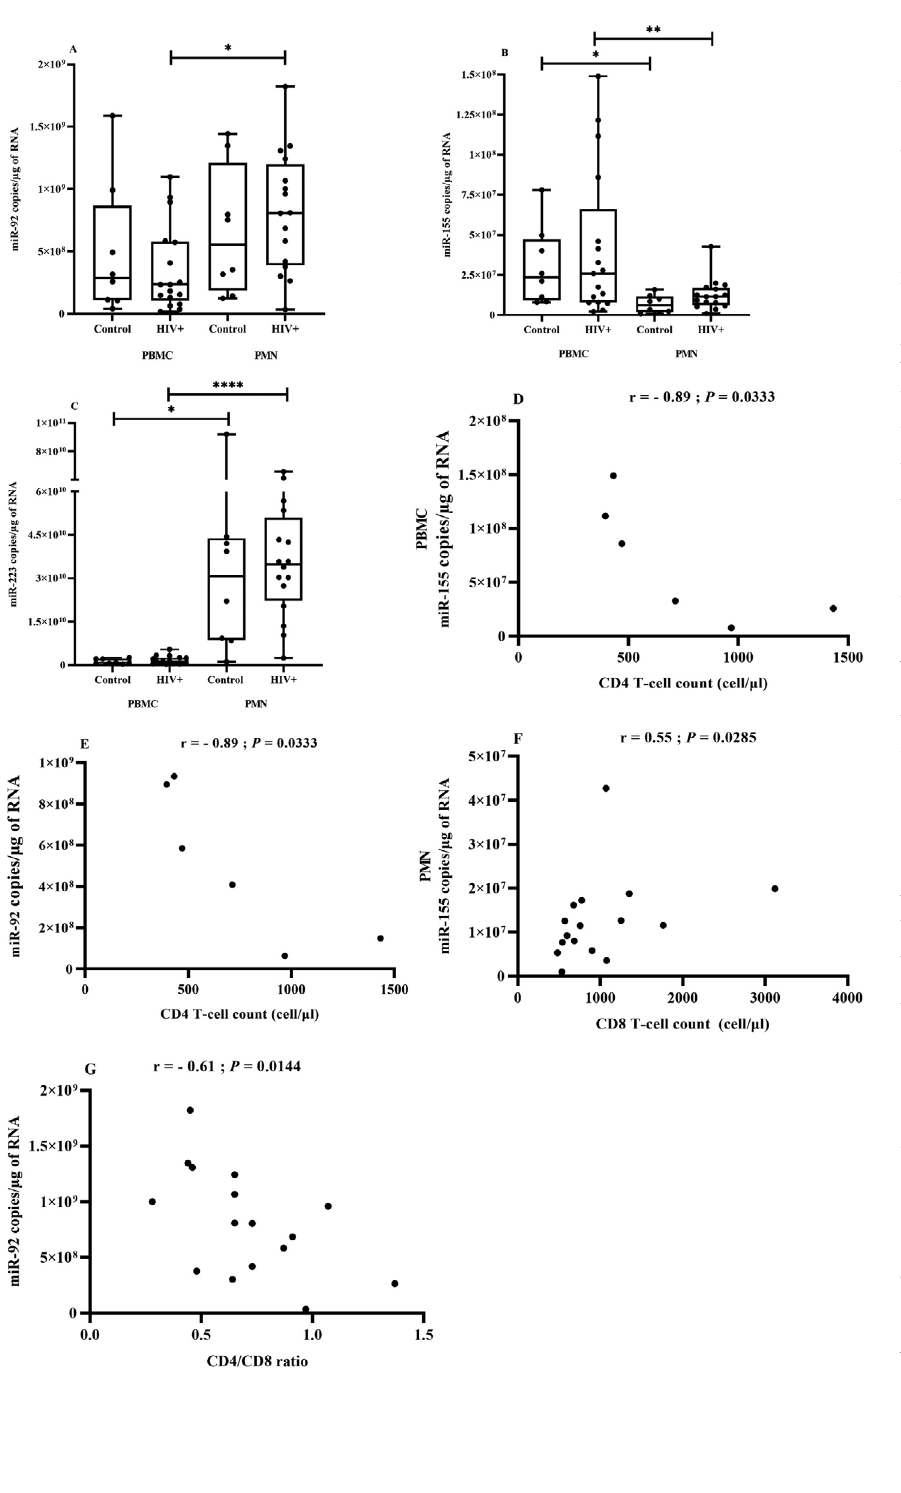
and T-cell count. (Figure correlation with count, (Figure 5E) miR-92 in PBMCs with CD4 T-cell count, (Figure 5F) miR-155 in PMNs with CD8 T-cell count, (Figure 5G) miR- 92 in PMNs with CD4/ CD8